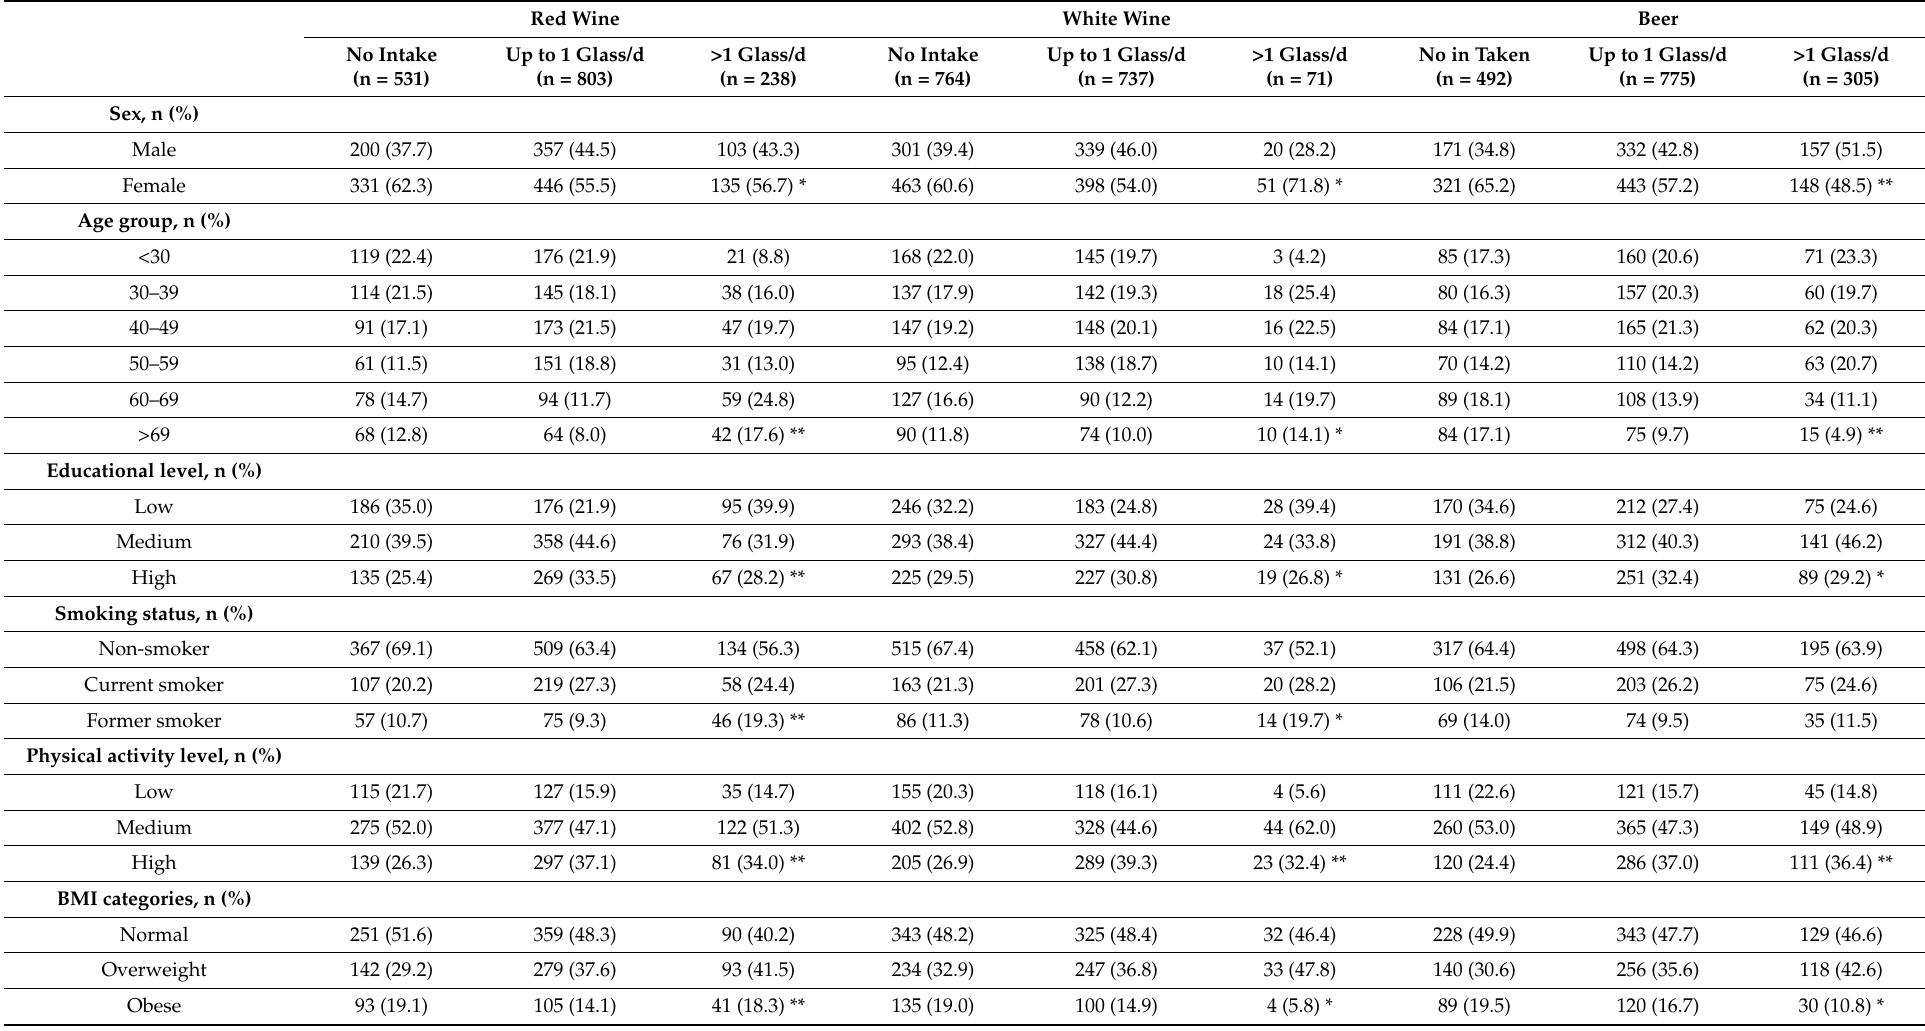
Table 3. Background characteristics of the study sample by consumption of individual alcoholic polyphenol-rich